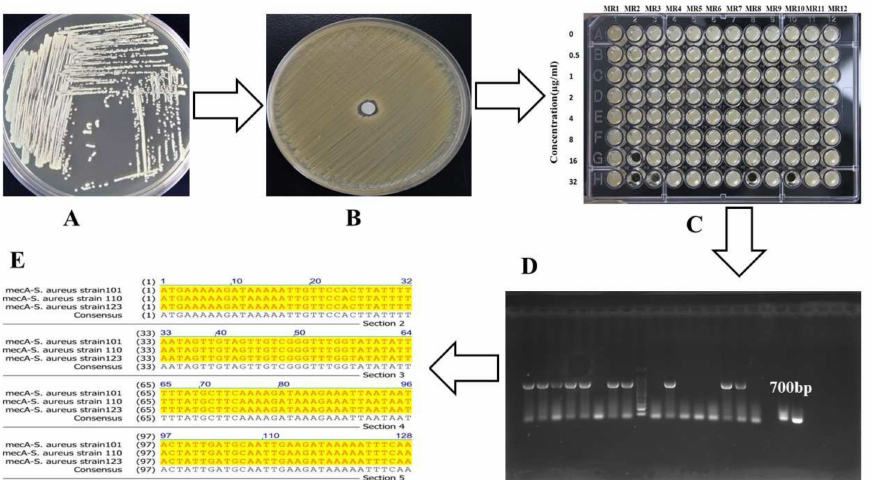
Figure 1. This figure summarizes the schematic diagram of screening resistant isolates from COVID-19 patients. ( A ) A single colony was streaked on TSA plate for antibiotic sensitivity testing. ( B ) The isolated strain antibiotic sensitivity testing was performed on Mueller–Hinton agar, and methicillin-resistant strains were selected. ( C ) The isolated strains MIC against methicillin, tazobac- tam, ciprofloxacin, etc. were determined by two-fold broth microdilution method ranges from 0 to 32 µ g/mL and higher (512 µ g/mL), while MR1–MR12 represent different strains. ( D ) mecA gene (700 bp fragment) was amplified from resistant isolates by PCR, and the product bands were visual- ized by gel electrophoresis, and ( E ) the PCR purified product of mecA gene (700 bp) was sequenced to confirm mecA detection. Table 1. The prevalence of MRSA and antibiotic resistance in COVID-19 patients. ND; not determined. mecA Number of Antibiotic Resistance Isolates